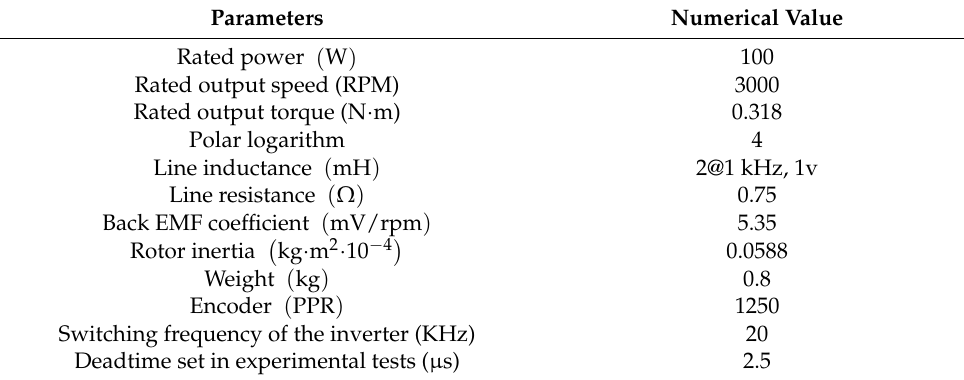
Table 1. Parameters of PMSM and test bed.